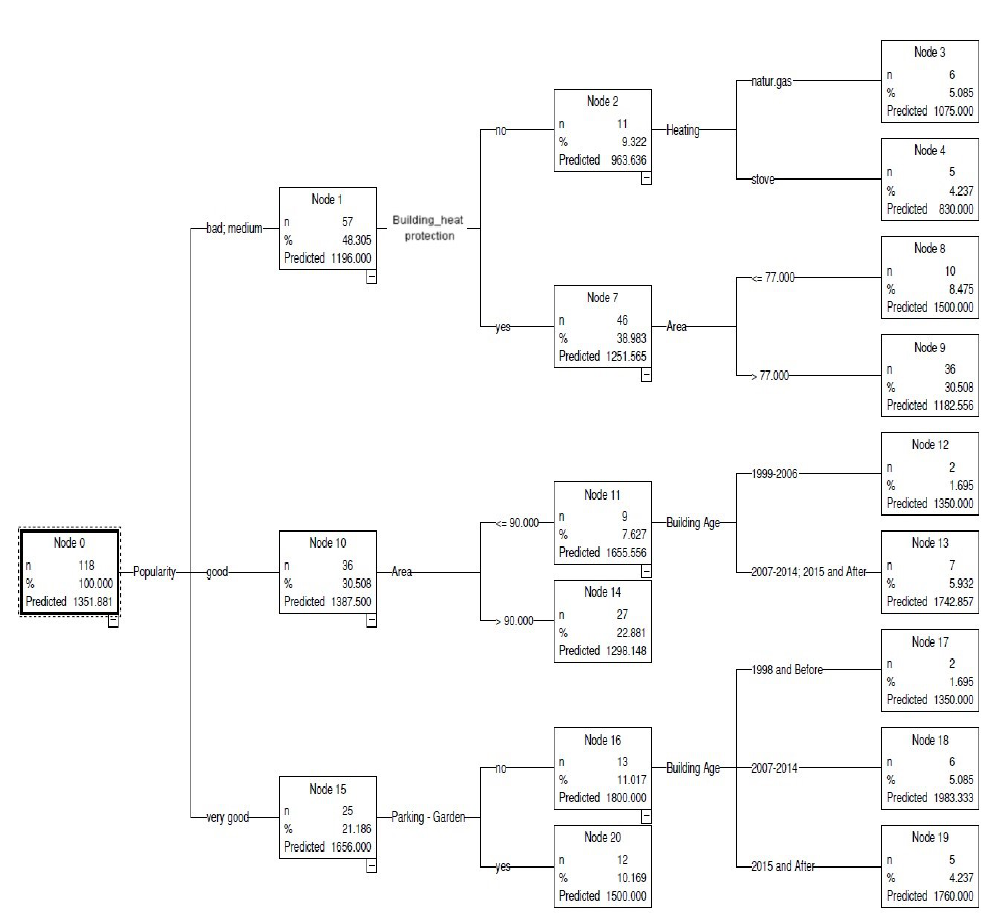
Fig. 11. CHAID algorithm results (developed by the